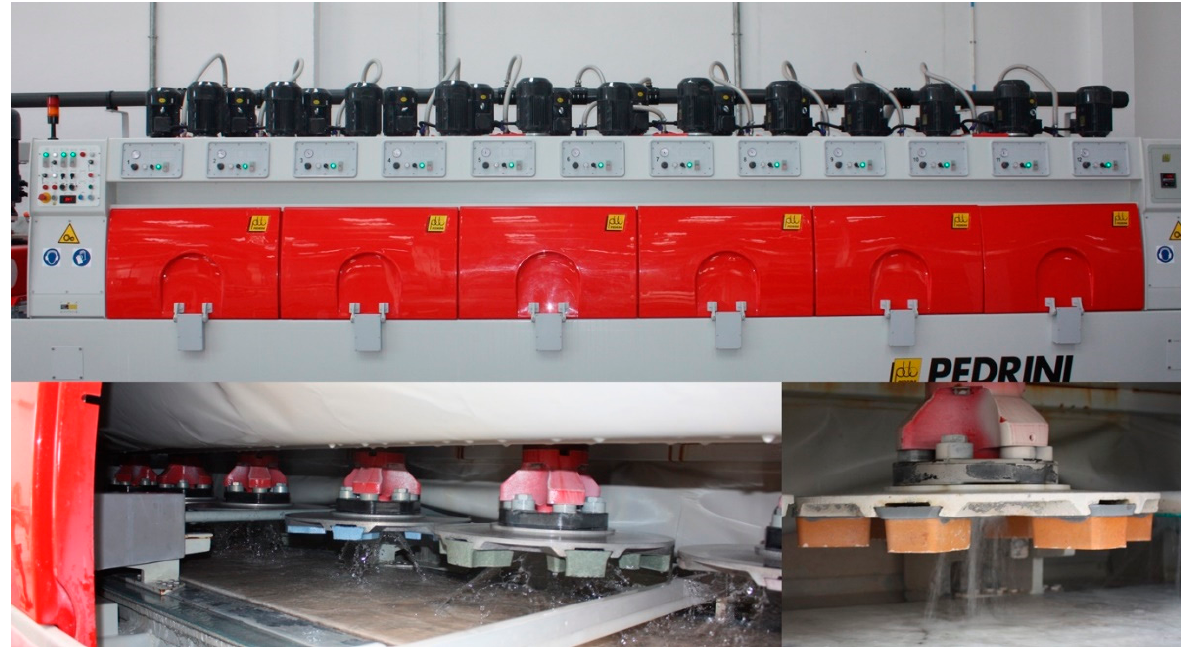
Figure 1. Aspects of a linear polishing machine with rotating heads (example from PEDRINI).